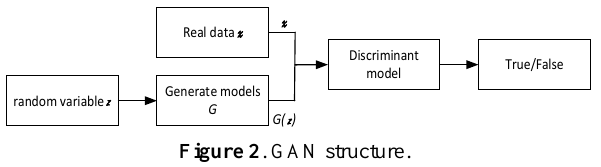
Figure 2 . GAN structure.